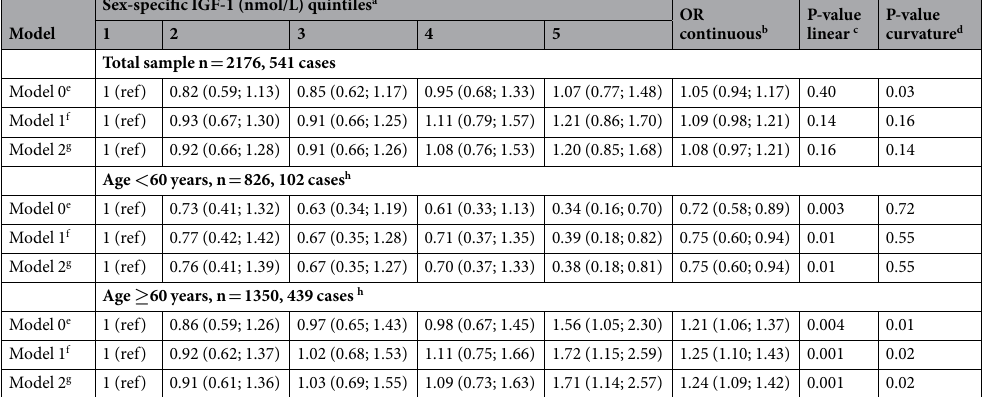
Table 3. Odds ratios (95% confidence interval) for hearing impairment in 2014 in relation to mean values of IGF-1 measured in 2008 and 2012 after exclusion of self-reported mild to severe hearing impairment at baseline: the English Longitudinal Study of Ageing (n = 2180). a IGF-1 (nmol/L) range in each quintile in the total sample: 3–13; 13.5–15.5; 16–18; 18.5–20.5; 21–35 (men) and 4.5–11; 11.5–13.5; 14–16; 16.5–19; 19.5–43 (women). Range in the younger group: 3–13.5; 14–16; 16.5–18; 18.5–21; 21.5–34.5 (men) and 4.5–12; 12.5–14.5; 15–17; 17.5–20.5; 21–43 (women). Range in the older group: 6.5–12.5; 13–15; 15.5–17.5; 18–20.5; 21–52 (men) and 4.5–10.5; 11–13; 13.5–15; 15.5–18; 18.5–38 (women). b Odds ratio (95% confidence interval) for the increase of 5 nmol/L of IGF-1 concentration when IGF-1 is included as a continuous variable in the model. c p-value of the effect of IGF-1 included as continuous in the regression model. d p-value derived comparing a nested model with a linear or linear and cubic spline terms. If the p-value is low ( < 0.05), this denotes evidence of a non-linear relation. e Model 0: Adjusted for age (continuous) and sex. f Model 1: Model 0 + height (continuous), smoking status (never, ex-smoker, current), body mass index (BMI, continuous kg/m 2 ), cognitive function (continuous score) at baseline and change, educational level (low, medium, high), physical activity (categorical, 5 levels), self-rated poor health (binary) at baseline and change. g Model 2: Model 1 + self-rated hearing acuity at baseline (excellent, very good). h P-value for interaction term between IGF-1 and age was 0.005 (Model 0), 0.008 (Model 1) and 0.01 (Model